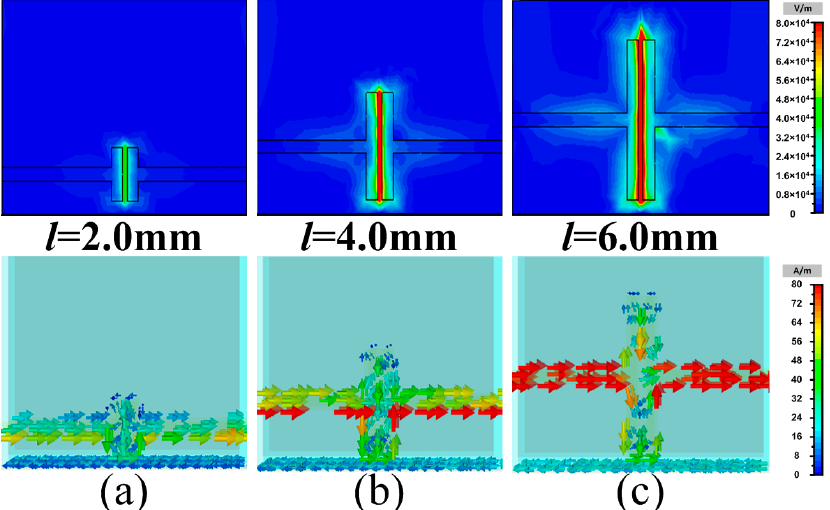
Figure 5. Electric field intensity distributions and surface current distributions of the proposed MAs with different widths of metallic bamboo joints: ( a ) l = 2.0 mm at the frequency of f = 4.4 GHz; ( b ) l = 4.0 mm at the frequency of f = 3.3 GHz; and ( c ) l = 6.0 mm at the frequency of f = 2.5 GHz,